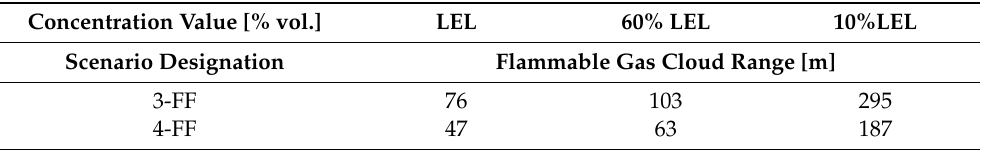
Table 8. Flammable gas cloud range (specified